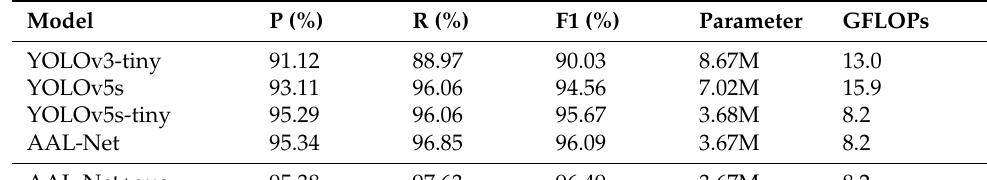
Table 4. Comparison of experimental results with existing methods in the pothole600 dataset.